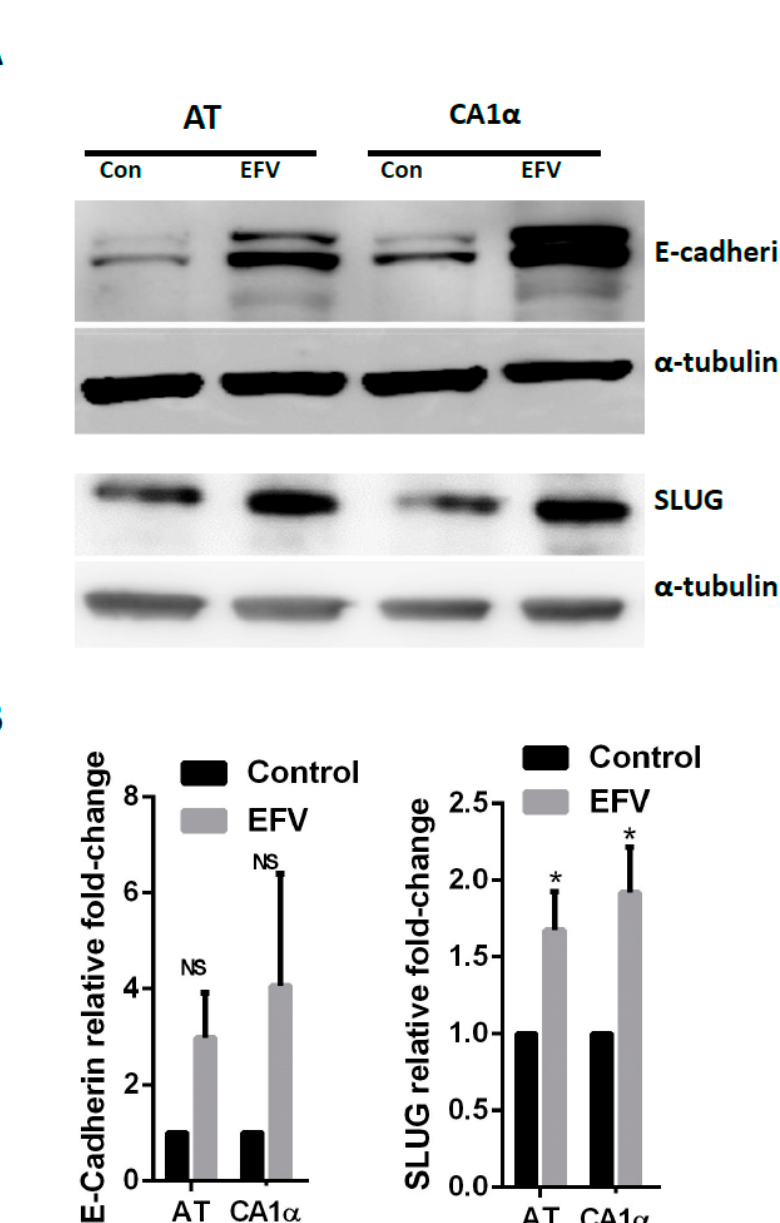
Figure 2. Efavirenz-induced molecular change in breast cancer cells. ( A ) The expression of E-cadherin (epithelial marker) increased in Efavirenz-treated MCF10AT and MCF10CA1 α cells. The expression of SLUG (mesenchymal marker) also increased in drug-treated breast cancer cells. ( B ) Normalized fold change of E-Cadherin and SLUG. Error bars: ± SD, n = 3. (paired Student’s t -test, * p < 0.05).